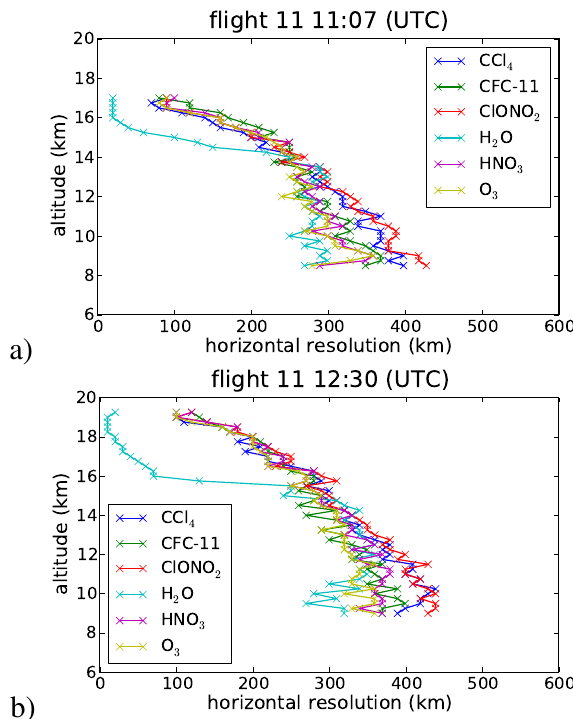
Fig. 9. Horizontal resolution along LOS for CCl 4 and CFC-11, and CFC-11, ClONO 4 ClONO 2 , H 2 O, HNO 3 and O 3 for profiles at 11:07 in (a) and 12:30UTC in (b)